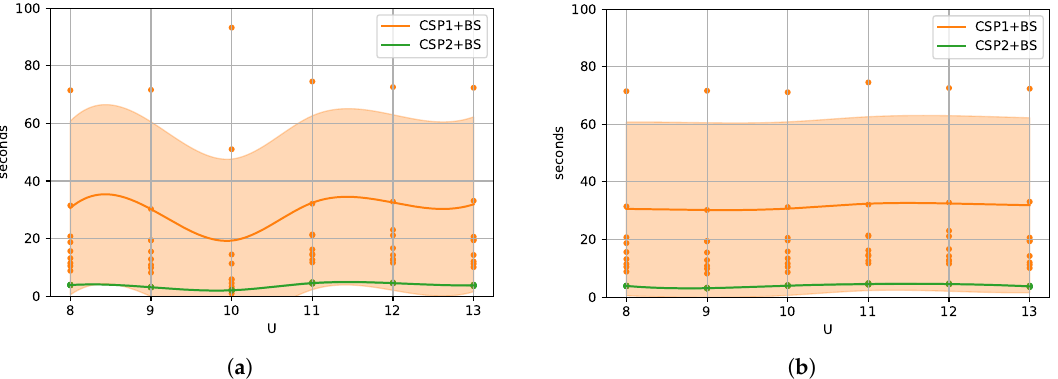
Figure 3. ( a ) Time to the optimal solution and ( b ) to proven optimality reported by Gurobi for the CSP1 + BS and CSP2 + BS over 10 random graphs of order 100, p = 0.02, and b ( G ) = 8. The bounds are L = 1 and U ∈ [ b ( G ) , (cid:100) ( 4 · 100/3 ) 1/2 (cid:101) + 1 ] .